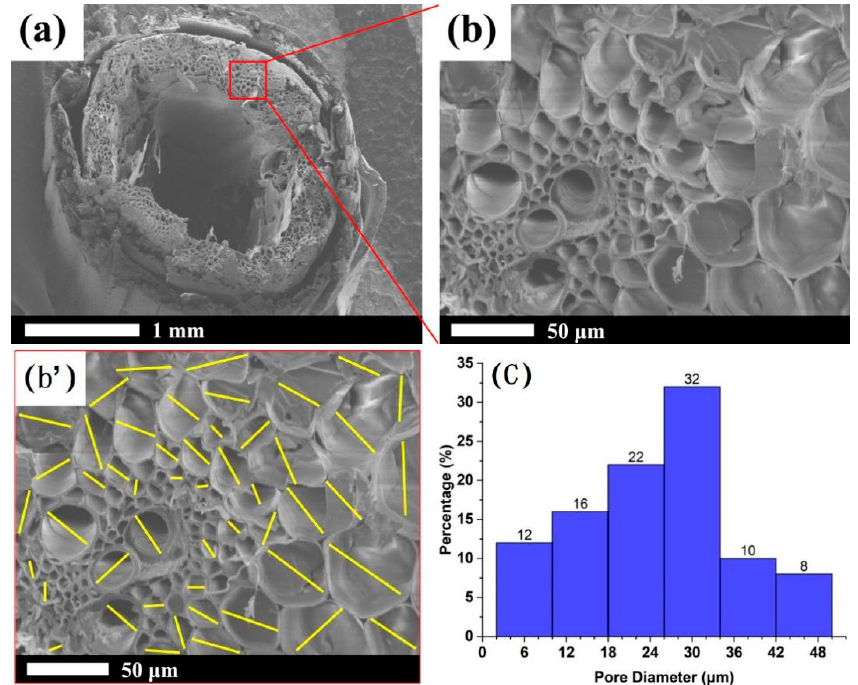
Figure 5. SEM micrograph of the straw core material: cross-section of single straw ( a ), partial enlarged detail ( b ), sampling tags of pore size for straw core ( b’ ) and pore size distribution graph ( c ).